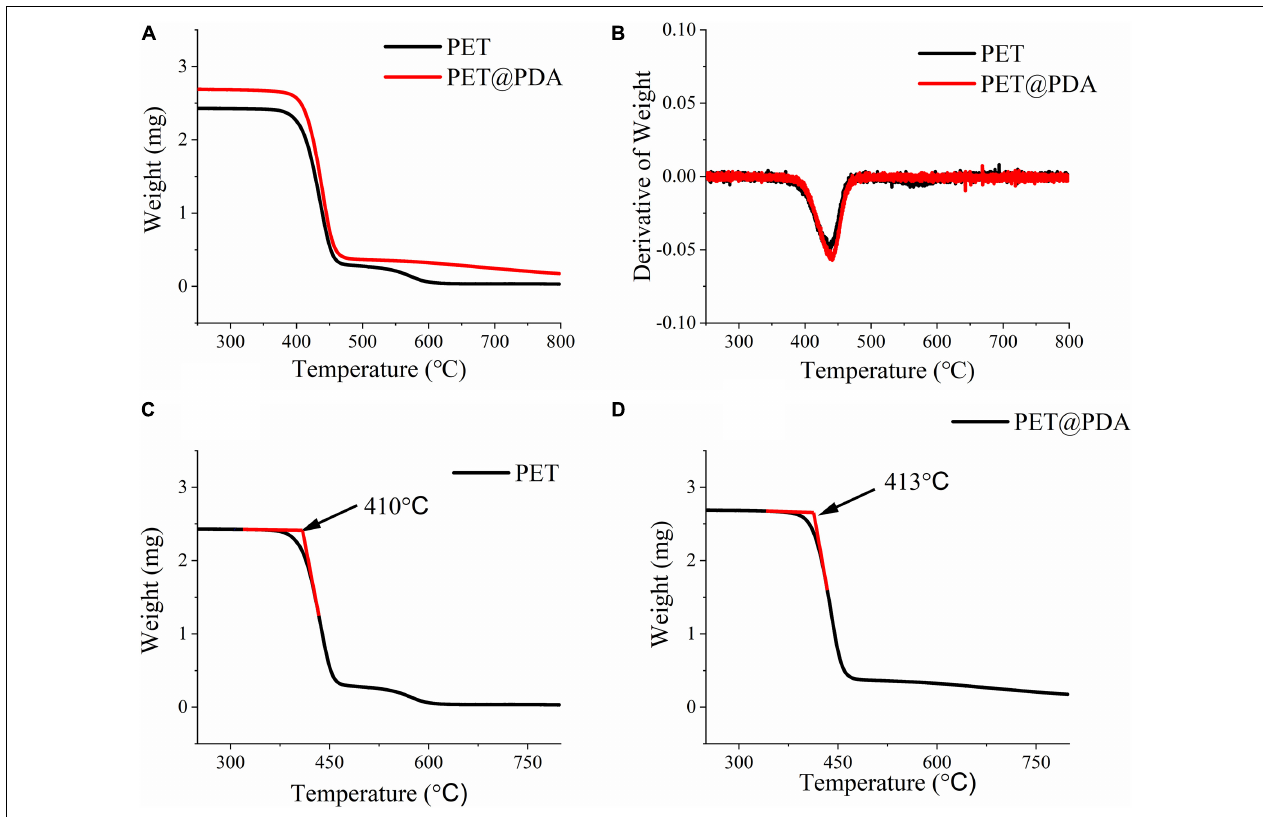
FIGURE 4 | Thermal gravity curve (A) and differential thermal gravity curve (B) of PET and PET@PDA ligament. Onset decomposition temperature of PET (C) and PET@PDA (D)